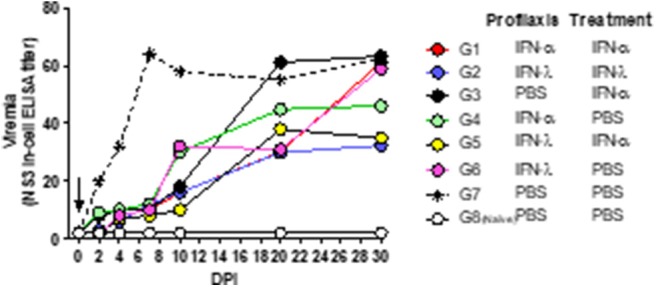
Effect of combined treatment in viremia. In the figure, the kinetics of viral replication in pools of serum, expressed as NS3 titers, is plotted as a function of the days post-infection (DPI). The arrow marks the time of infection. The key to the experimental groups to the right of the figure, summarizes the IFN-pre- and/or –post-infection protocol for each of the experimental groups (G1–G8).